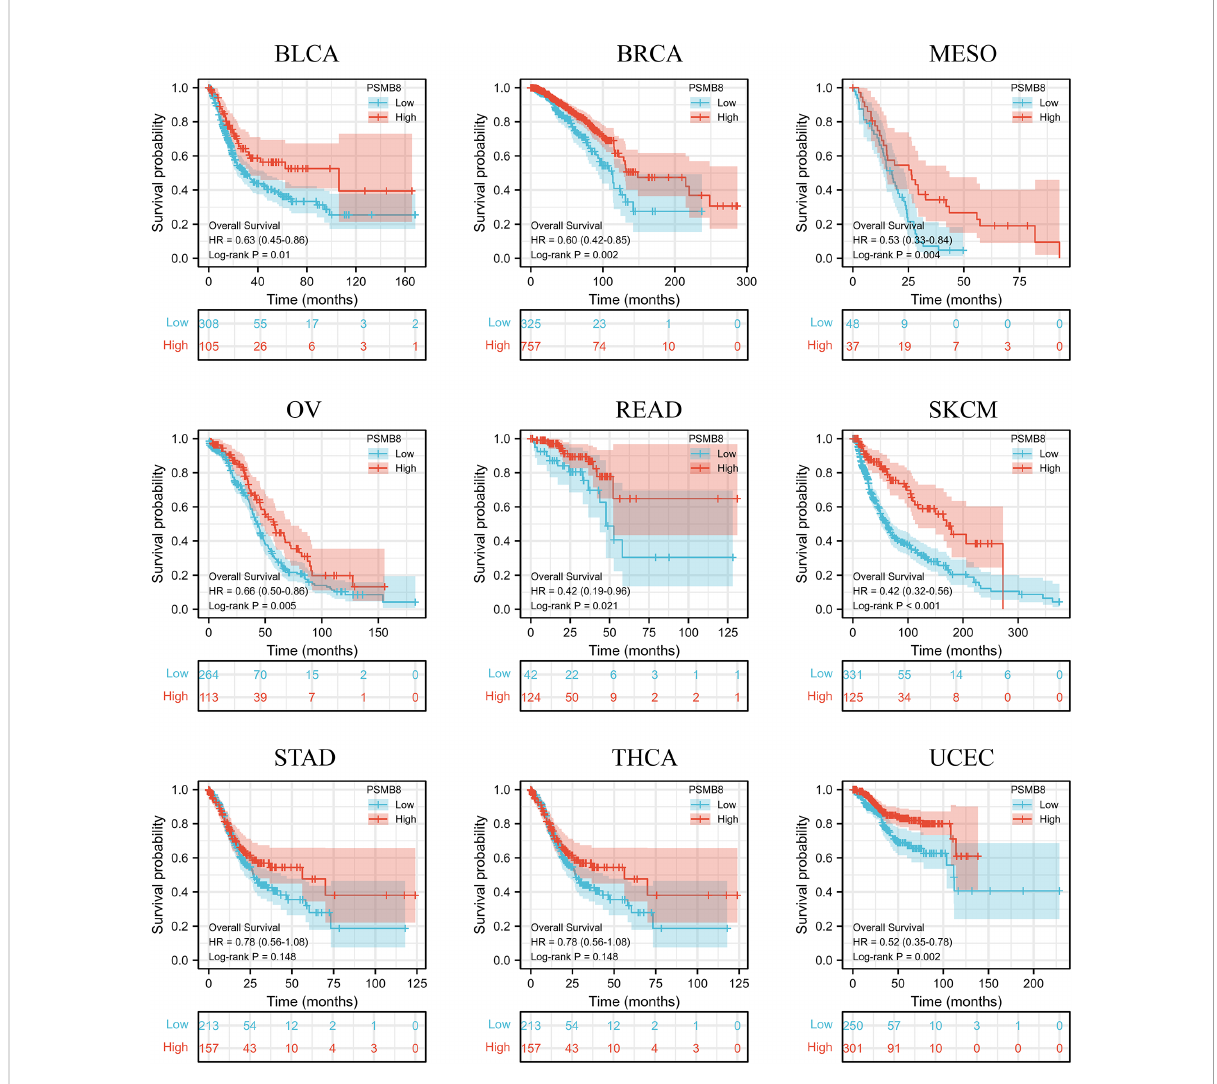
FIGURE 3 In different cancers, survival and prognosis analysis of PSMB8 showed that PSMB8 high expression group had a better